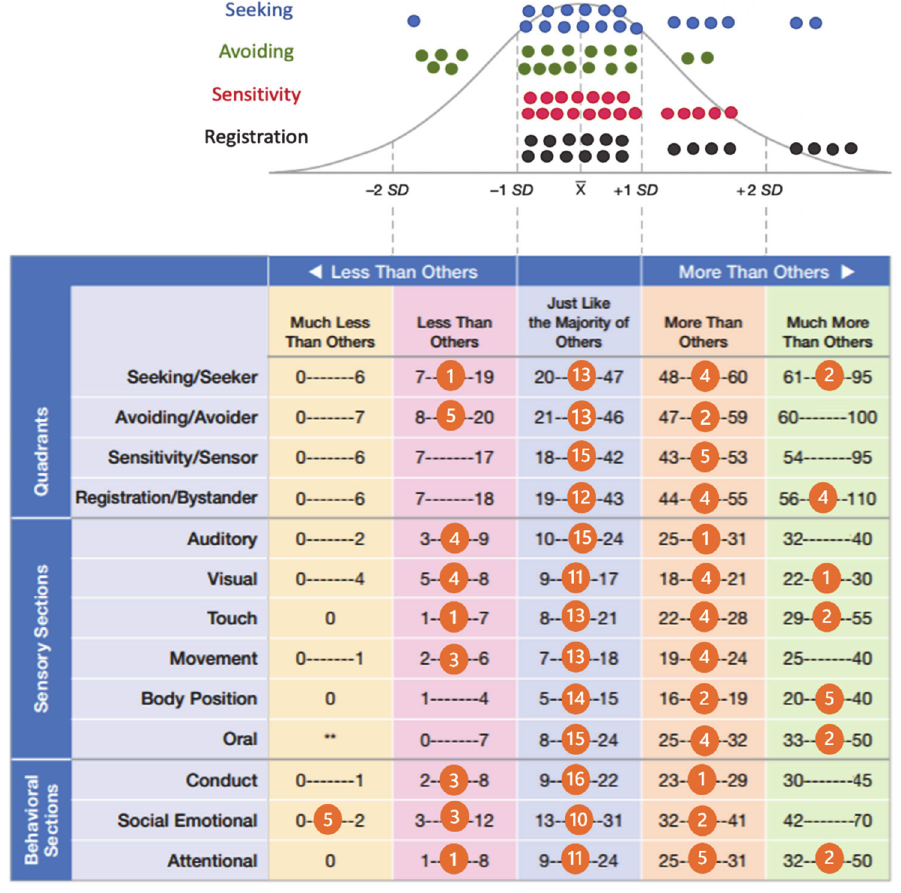
Table 3. Correlations between Vineland subscales and SSS and BPIs subscales.